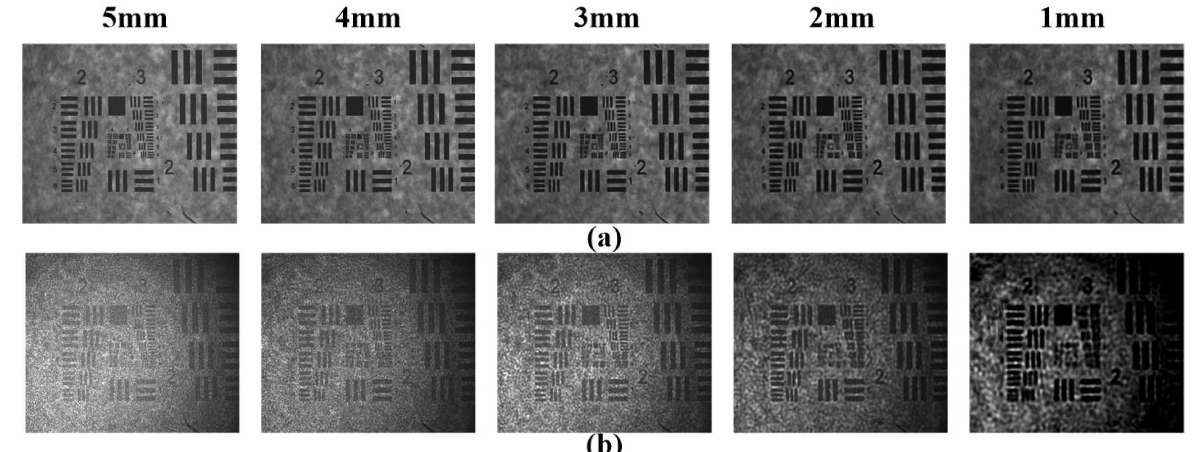
Figure 3. Fourier spatial filtering imaging of different spatial gate sizes: ( a ) SC illumination and ( b ) femtosecond laser illumination.